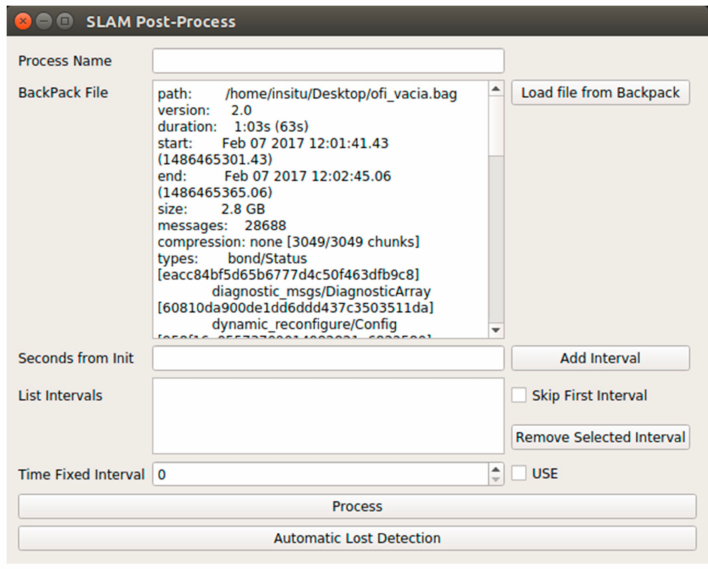
Figure 4. SLAM configuration window, for the definition of processing intervals and the determination of the steps of the process to